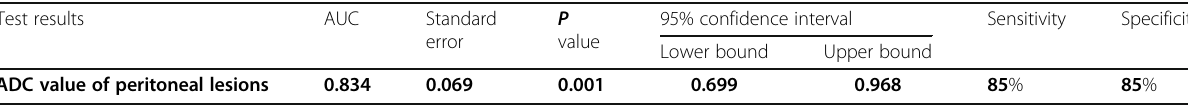
Table 5 AUC and 95% confidence